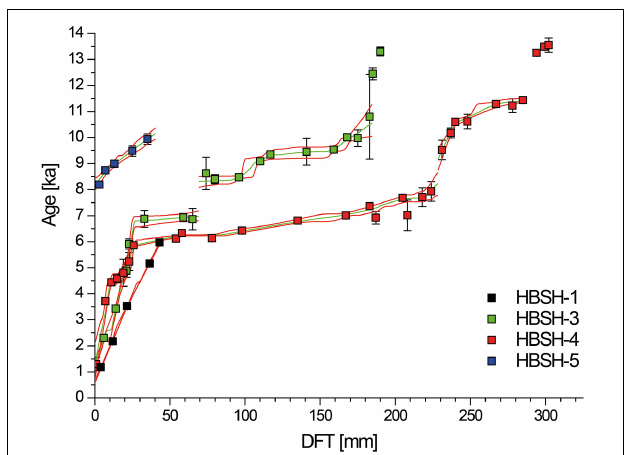
FIGURE 3 | Age-depth relationships for stalagmites HBSH-1 (black), HBSH-3 (green), HBSH-4 (red), and HBSH-5 (blue). The colored squares represent the individual 230 Th/U-ages with their respective 2 SE uncertainties. Note that some of the error bars are smaller than the symbols. Detailed uncertainties are given in Table 1 . The green lines represent the age models calculated by StalAge (Scholz and Hoffmann, 2011) with the red lines representing the corresponding age uncertainties at the 95% confidence level for each sample. For the sections corresponding to the periods prior to the onset of the Holocene in stalagmites HBSH-3 and HBSH-4, no age model was calculated.